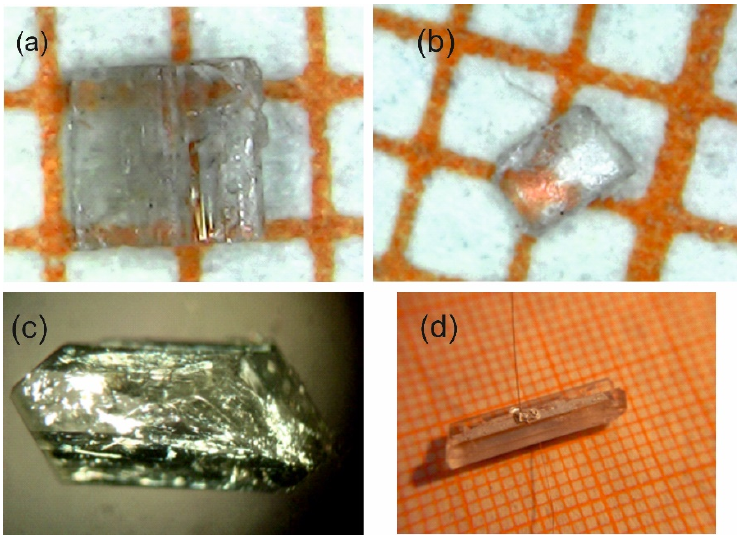
Figure 1. Photos of crystals of MBI-phosphite ( a,b ), MBI-phosphate-1 ( c ), MBI-phosphate-2 ( d ). The